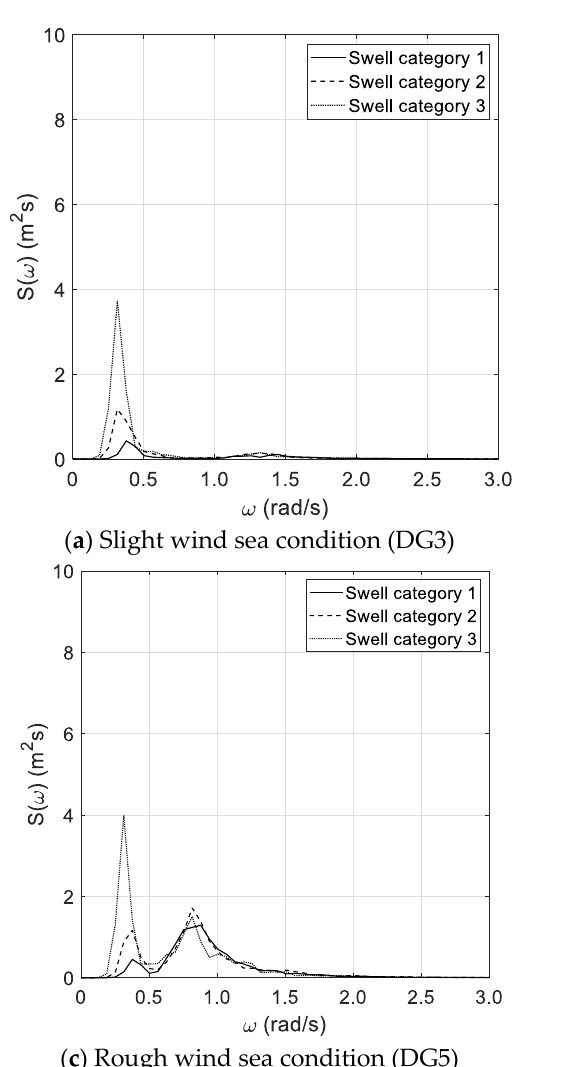
Figure 5. Spectral analysis (Thomson)—short duration with high frequency resolution.